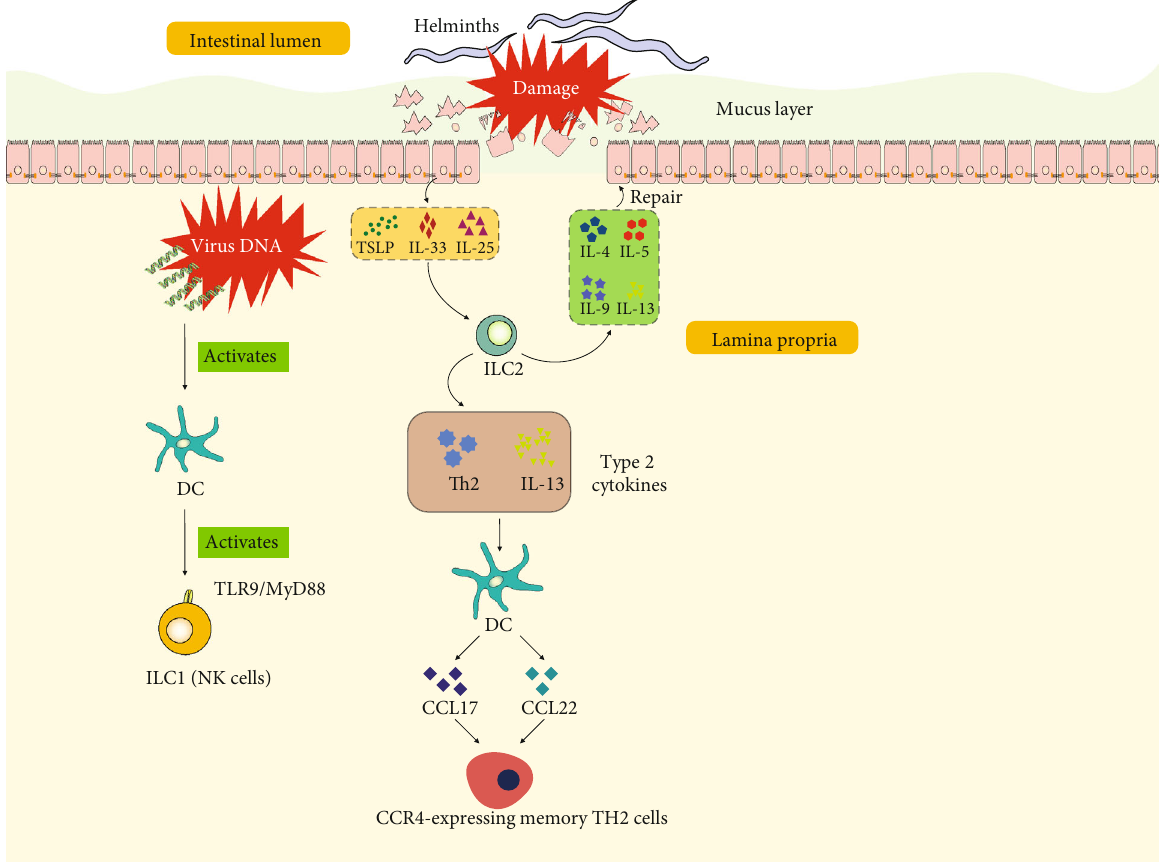
Figure 2: Illustration of interactions of ILCs and DCs in the intestinal tract. At the initial site of viral infection, virus DNA activates DCs, further activating ILC1 (mainly NK cells) by the TLR9/MyD88 pathway. After damage caused by helminths, epithelial cells produce TSLP, IL-33, and IL-25. These cytokines stimulate ILC2s producing type 2 cytokines including IL-4, IL-5, IL-9, and IL-13 which participate in repair of epithelial cells and mucus layer. In addition, ILC2-derived Th2 and IL-13 stimulate DCs, inducing the release of CCL17 and CCL22 and recruitment of CCR4-expressing memory TH2 cells. IL: interleukin; TSLP: thymic stromal lymphopoietin; DC: dendritic cell; ILC: innate lymphoid cell; CCL: chemokine (C-C motif) ligand; Th: helper T